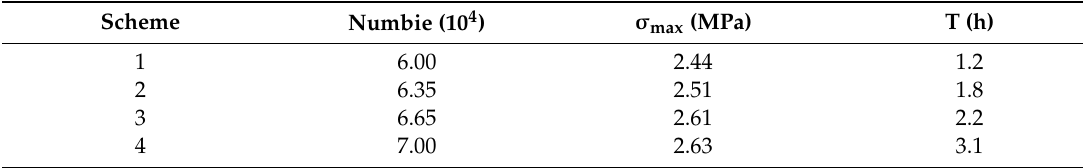
Table 2. Sensitivity analysis of the model mesh